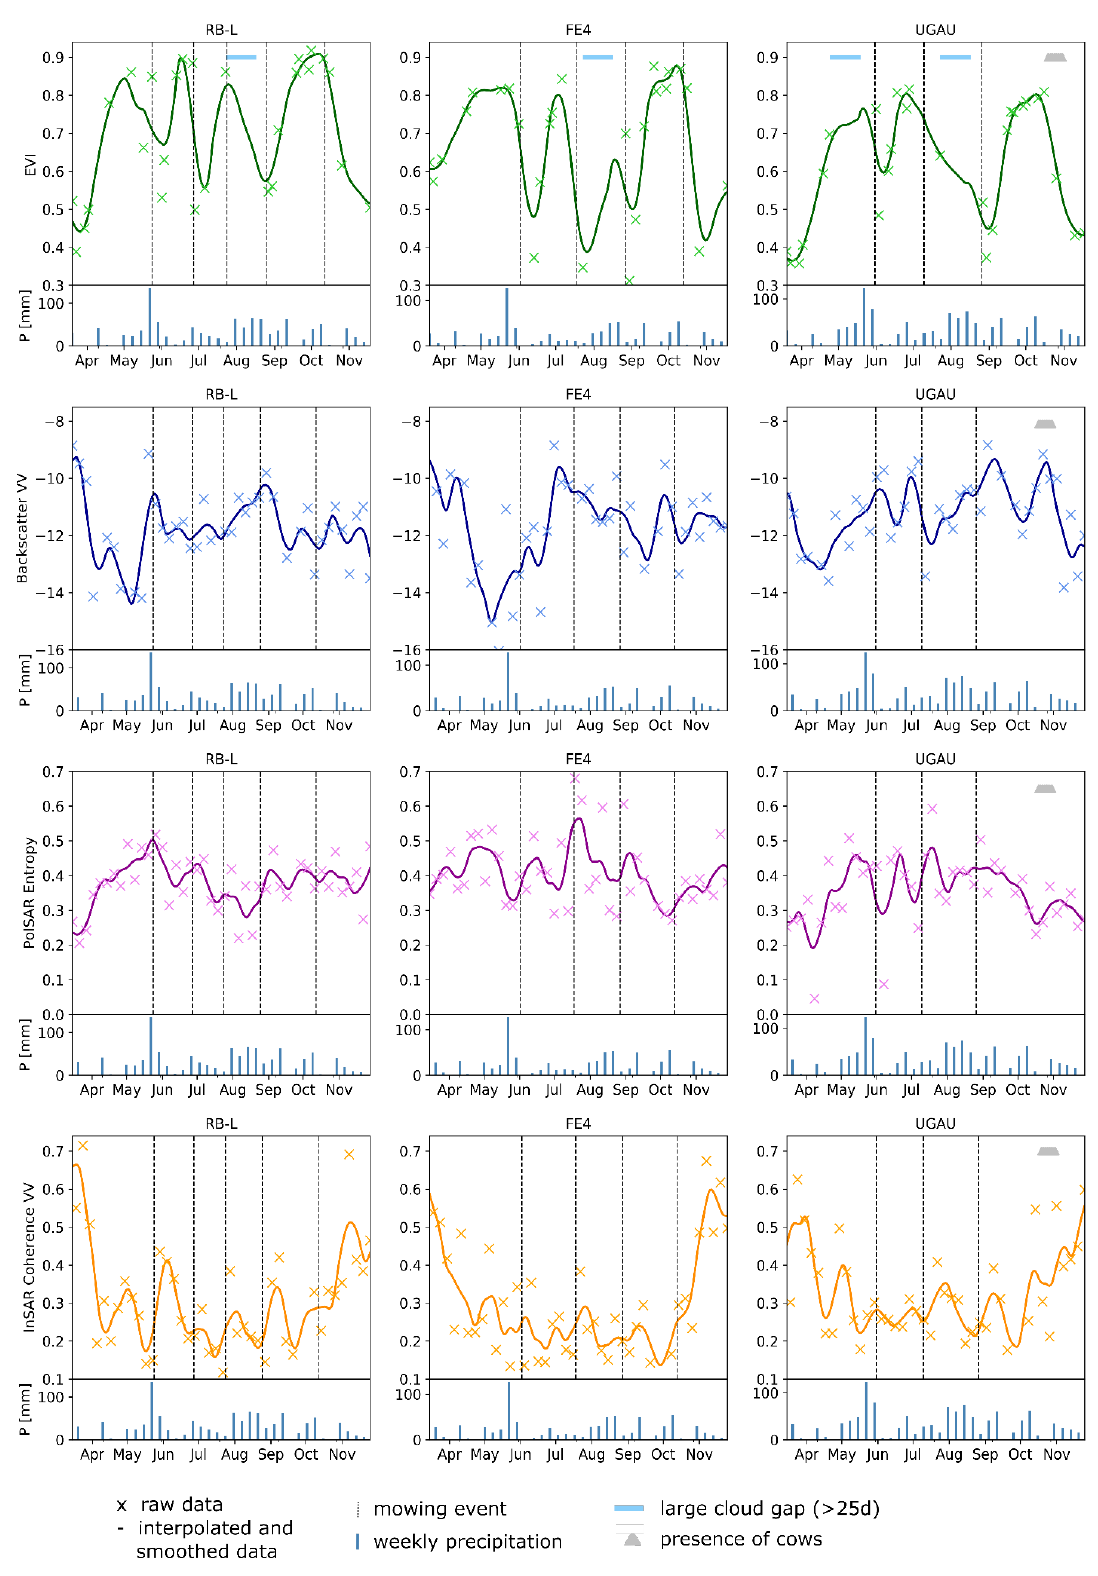
Figure 3. Time series of S2- and S1-based parameters for five (RB-L), four (FE4), and three (UGAU) times mown grassland parcels, including information on the mowing date (vertical lines), presence of cows, and large data gaps (>25 days) within the optical time series and weekly precipitation sums (bottom plots).